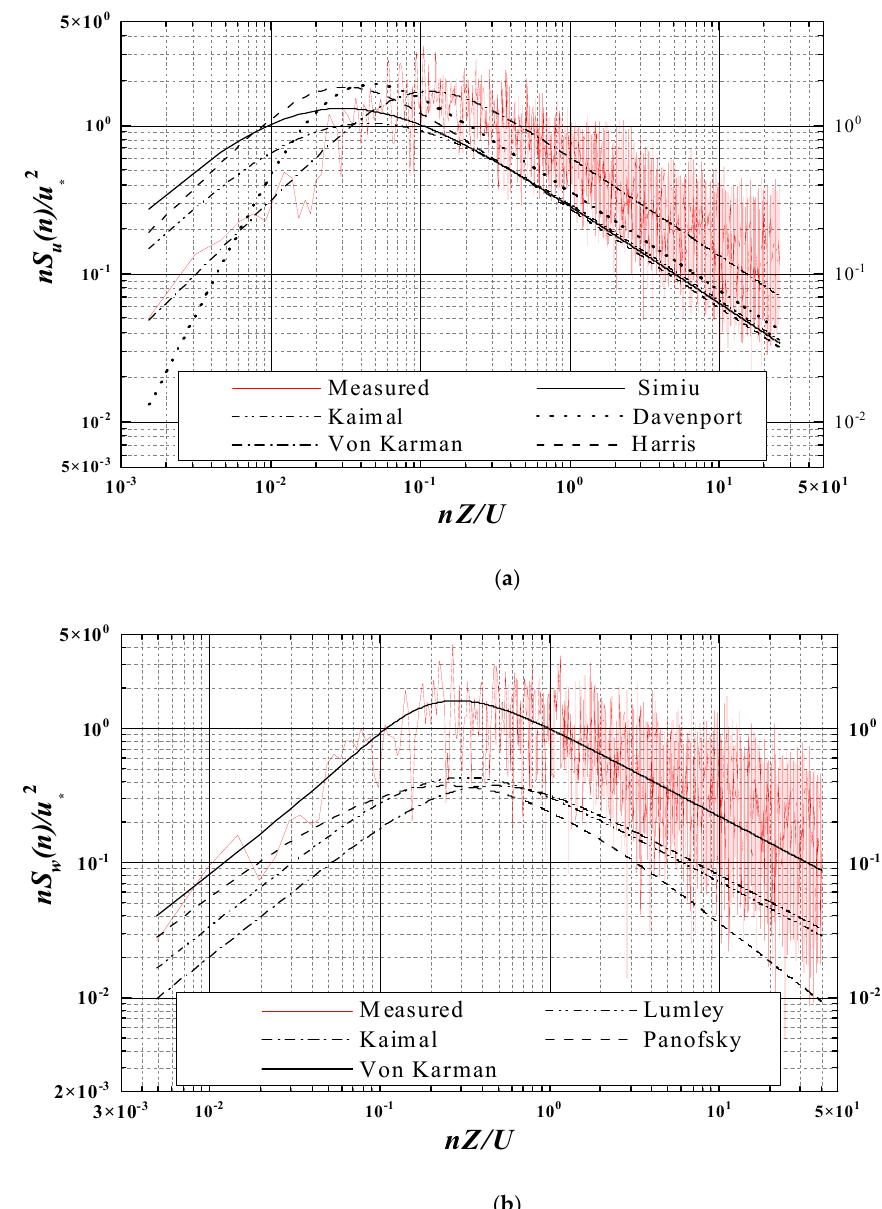
Figure 16. Spectrum of vertical turbulence at deck lever. ( a ) Component u; ( b ) component w.